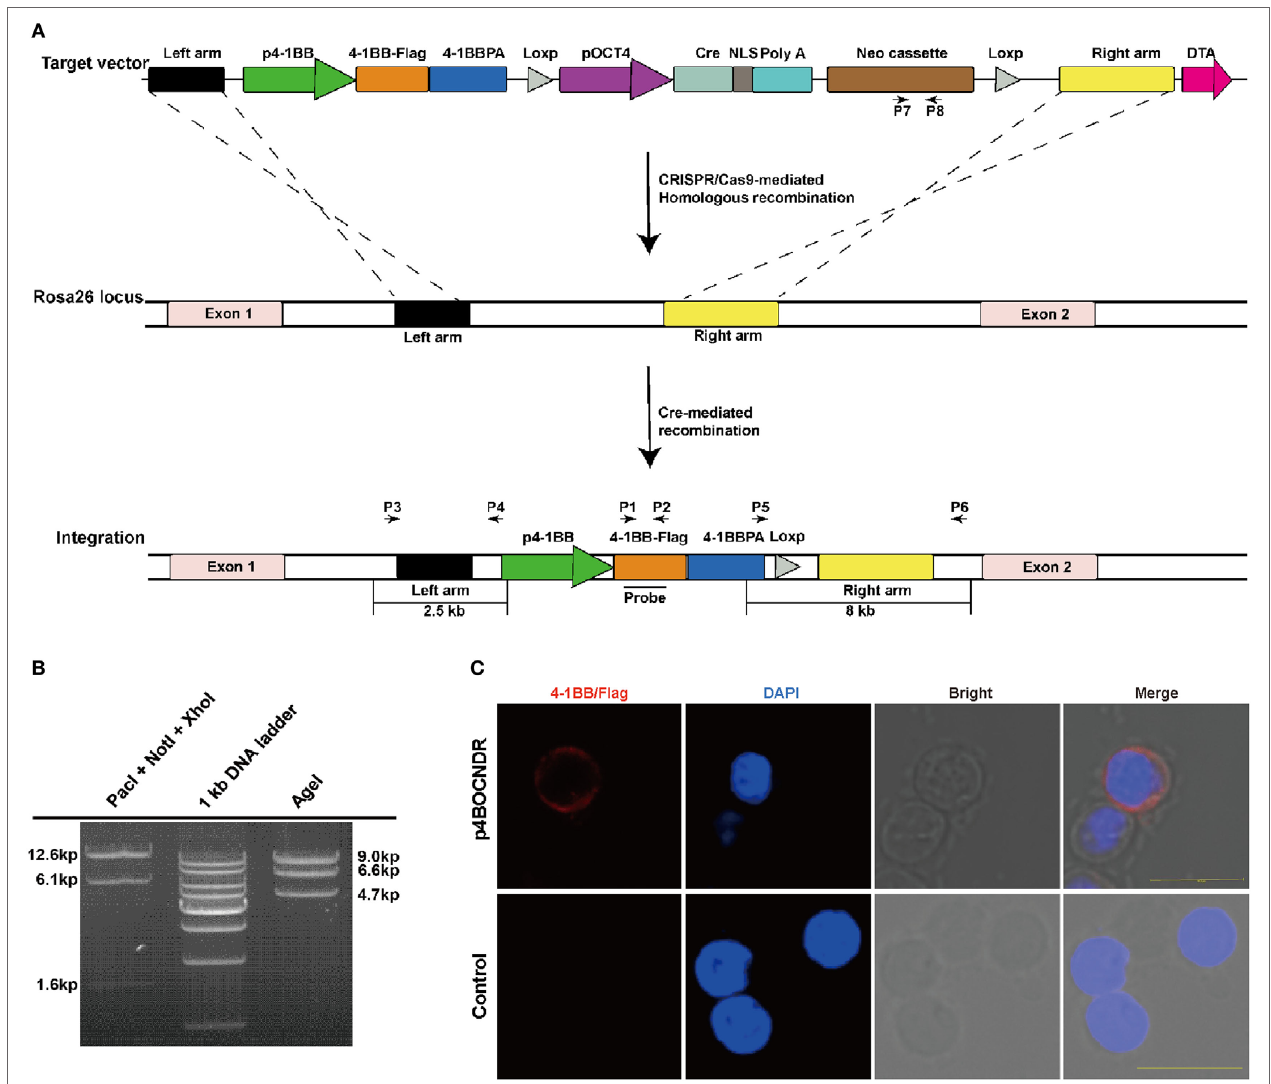
FigUre 1 | Construction and detection of the 4-1BB gene knockin vector for Rosa26 targeting. (a) A schematic diagram of genome editing strategy to target the Rosa26 locus in Sus scrofa via clustered regularly interspaced short palindromic repeats (CRISPR)/CRISPR-associated gene 9 (Cas9)-mediated homologous recombination and Cre -mediated recombination. The black arrows indicate the primers used for PCR assay. p4-1BB, 4-1BB promoter; 4-1BB, 4-1BB coding sequence; 4-1BBPA, 4-1BB 3 ′ untranslated region; pOCT4, OCT4 promoter; NLS, nuclear localization sequence; Neo, neomycin resistance gene; DTA,